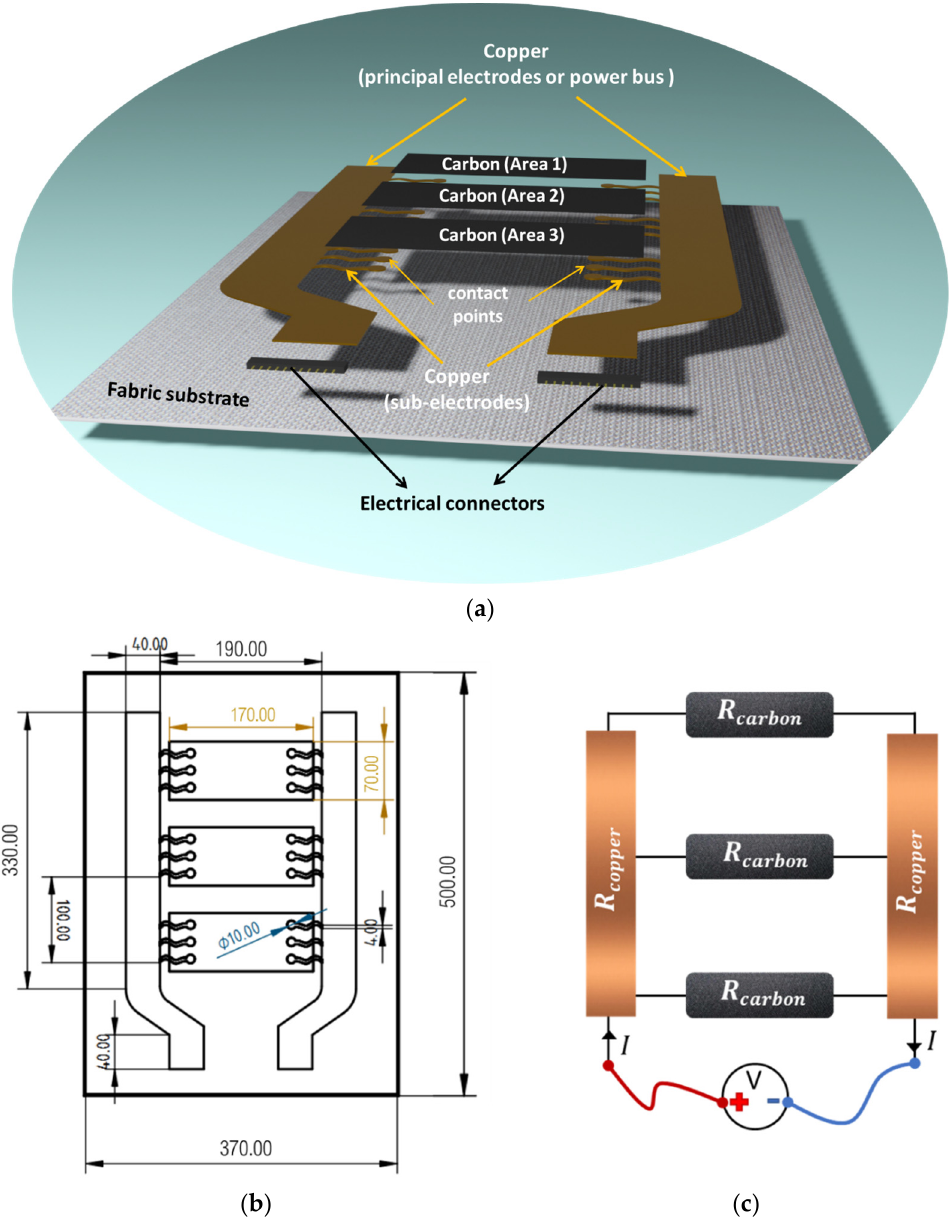
Figure 3. Design patterns of the heating fabric: ( a ) Heating system composed of copper tracks and carbon patches built on a fabric substrate. ( b ) 2D dimensions of the heater design. ( c ) Equivalent electrical scheme.